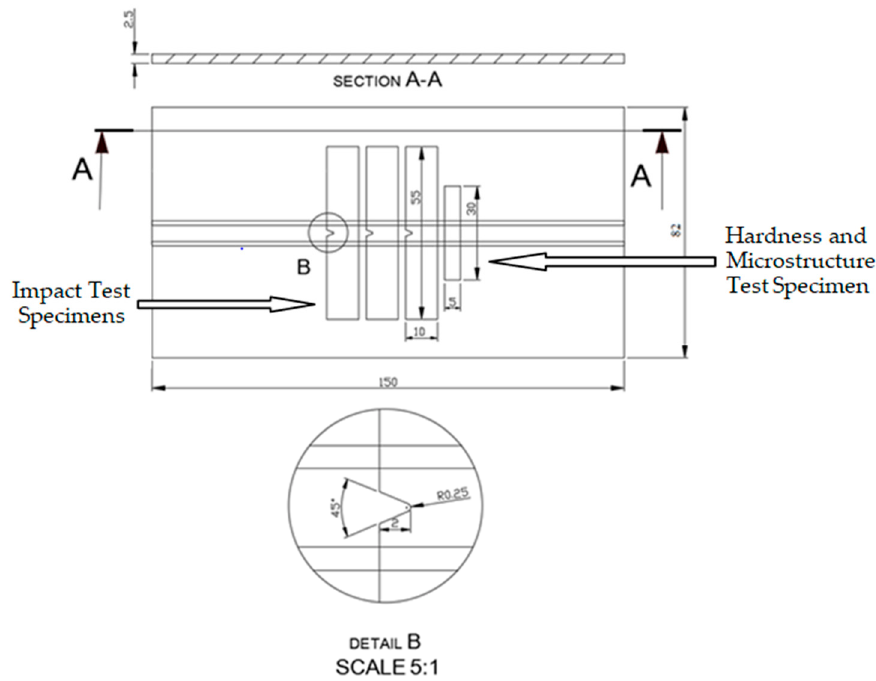
Figure 3. Test schedule on weldments according to ISO 15614-1 Standard.